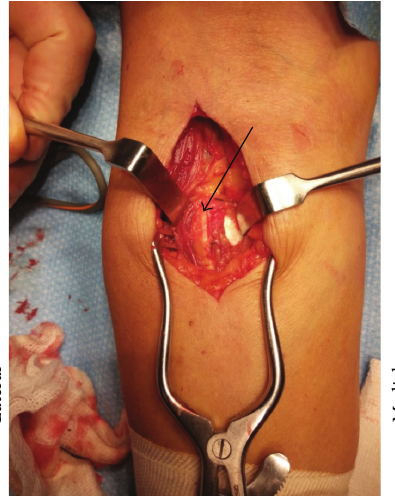
Figure 6: Deeper dissection exposing partial bursa and deep radial nerve (thin